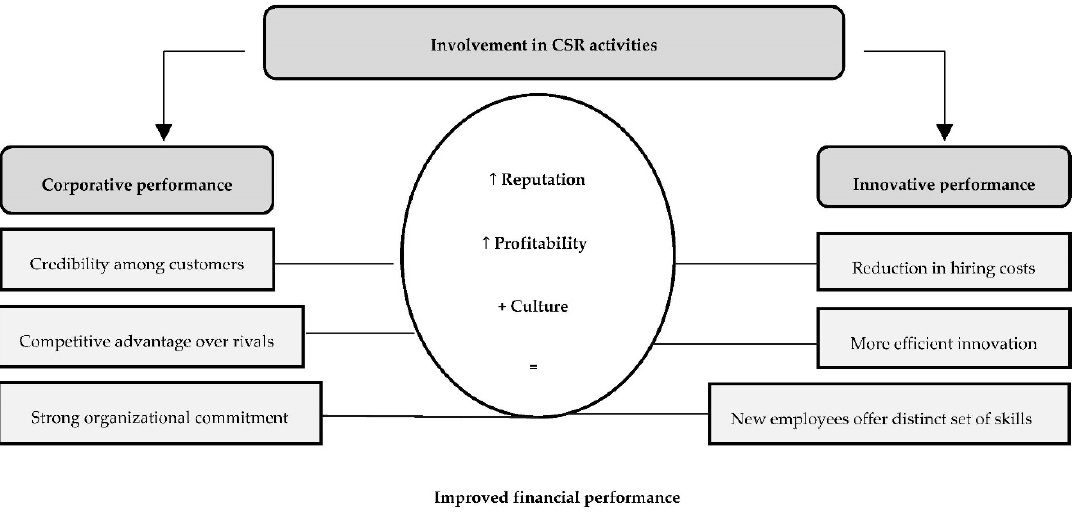
Figure 1. The impact of CSR on corporative and innovative performance.